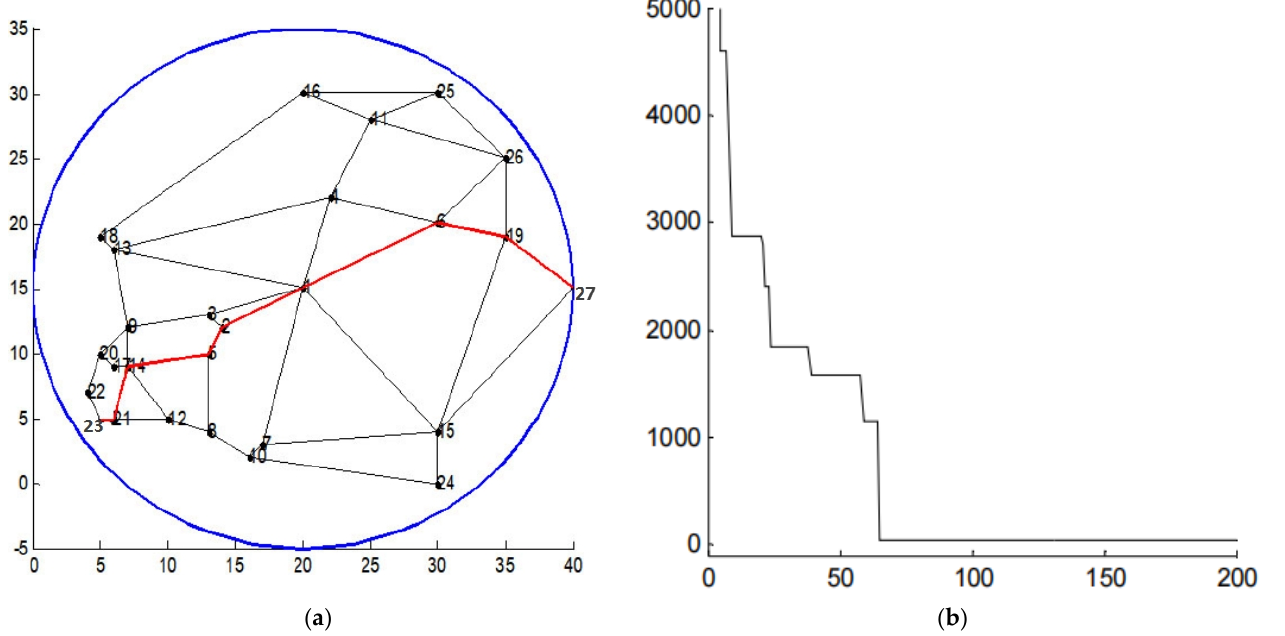
Figure 8. Distribution path ( a ) and the optimization curve ( b ). For ( a ), the 𝑥 - and 𝑦 -coordinates correspond to a position on a map. For ( b ), the 𝑥 -coordinate corresponds to the number of generations, and the 𝑦 -coordinate corresponds to the total route length in km.